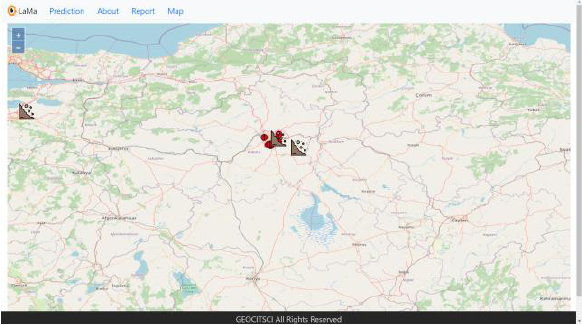
Figure 5. Interface of the web-map